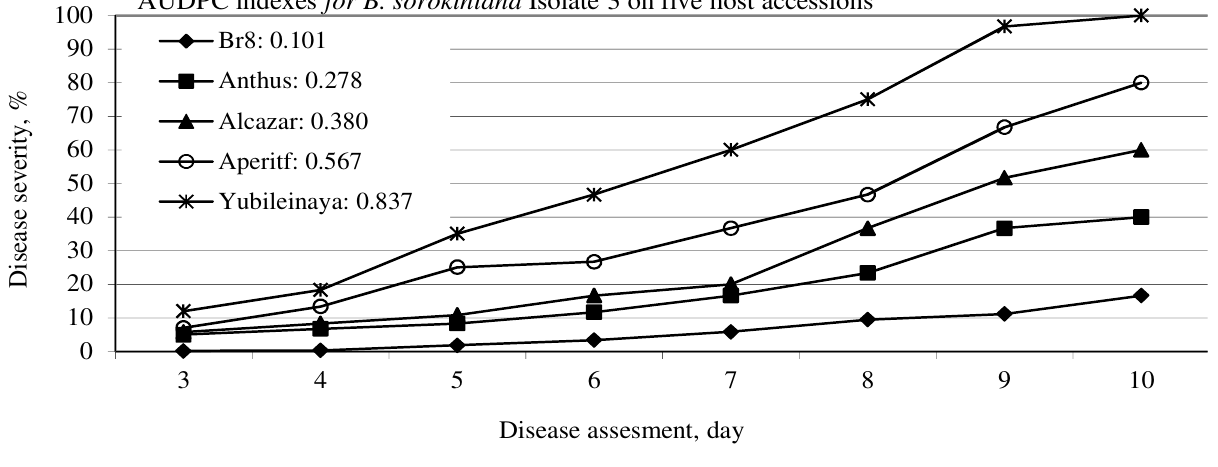
Figure 1. Development of spot blotch on wheat genotypes possessing diverse AUDPC indices. Fig. 1. Development of spot blotch on wheat genotypes possessing diverse AUDPC